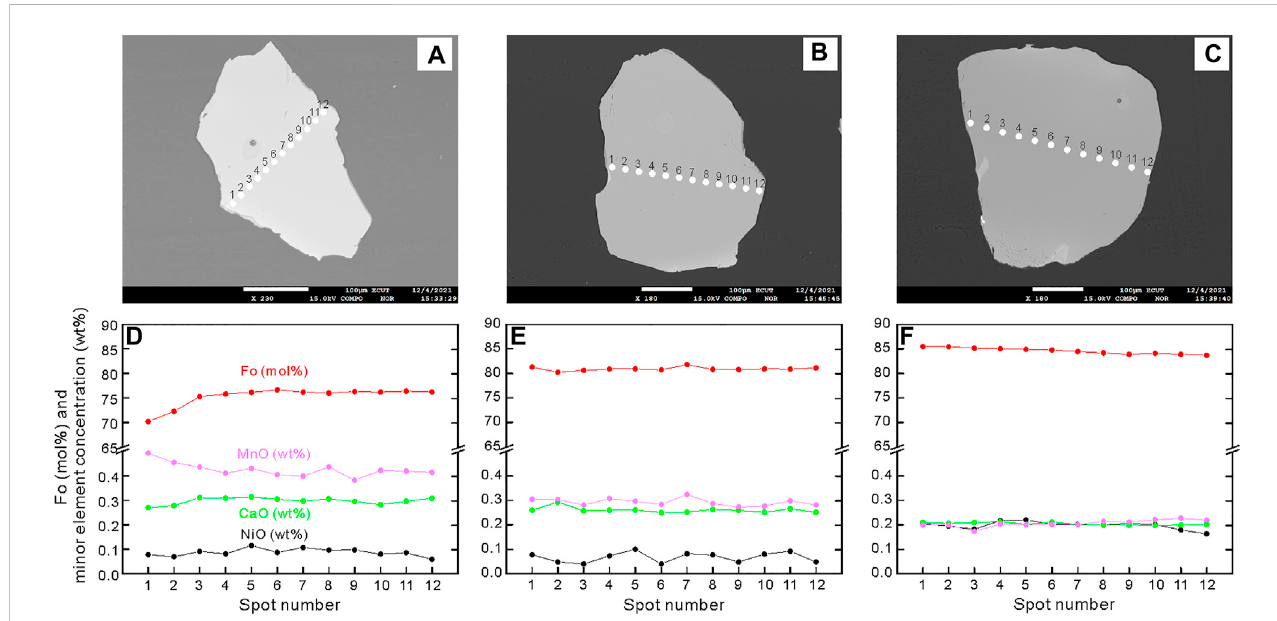
FIGURE 7 Back-scattered electron images and geochemical pro fi les of the Tengchong basalts. (A) Olivine from basalt in the western area with Fo~75; (B) olivine from trachybasalt in the central area with Fo~82; and (C) olivine from basalt in the eastern area with Fo~84. Plots (D – F) show several representative elements of the samples shown in plots (A – C) ,